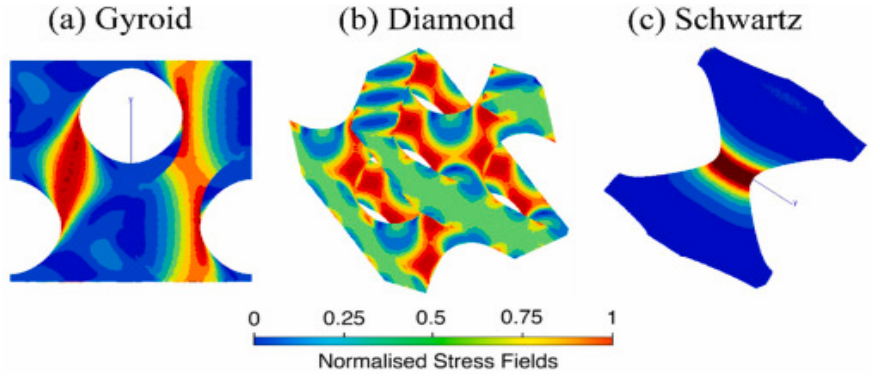
Figure 23. Crossland FIP distribution on the three different lattices. ( a ) Gyroid, ( b ) Diamond, ( c ) Schwartz. Reprinted with permission from ref. [83]. 2020, Elsevier.